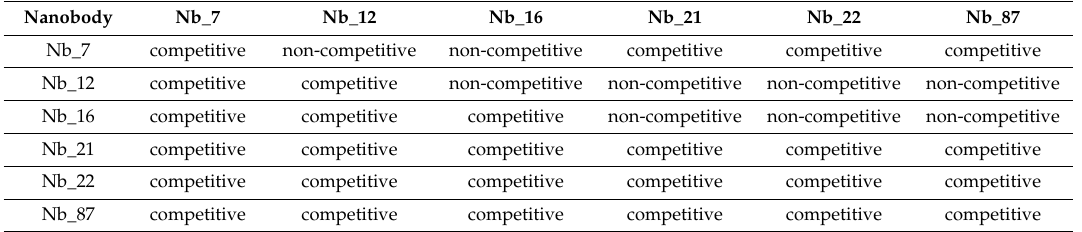
Table 2. Overview of the epitope binning experiments. Each pair of anti-CD33 Nbs is classified as noncompetitive if it recognizes a non-overlapping epitope, or as competitive if it binds to an overlapping epitope.